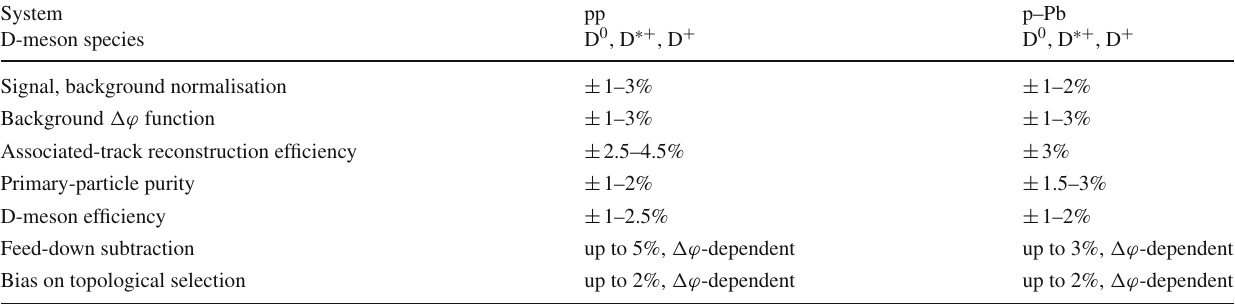
Table 1 List of systematic uncertainties for the azimuthal-correlation functions in pp and in p–Pb collisions. If not specified, the uncertainty does not depend on